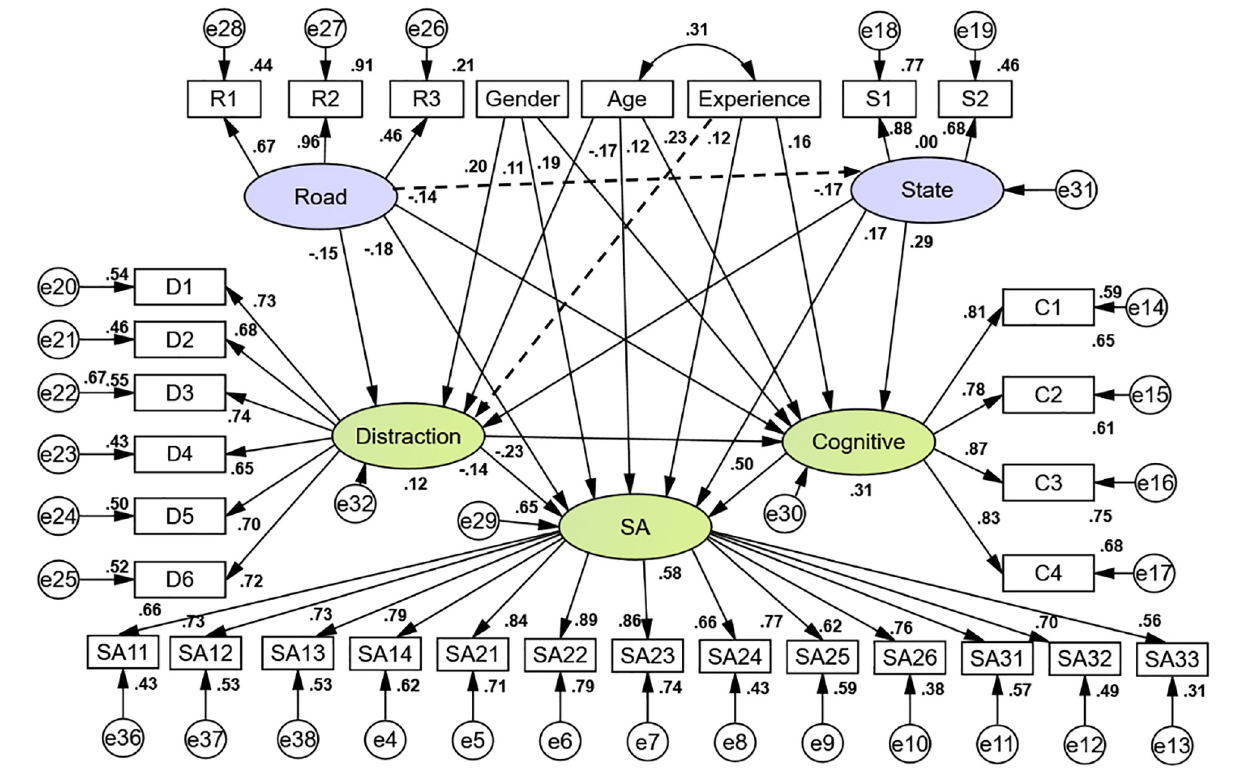
FIGURE 4 | Drivers’ SA influential factors path